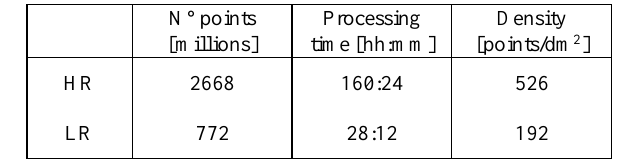
Table 11. Terrestrial photogrammetric dense point clouds statistics.